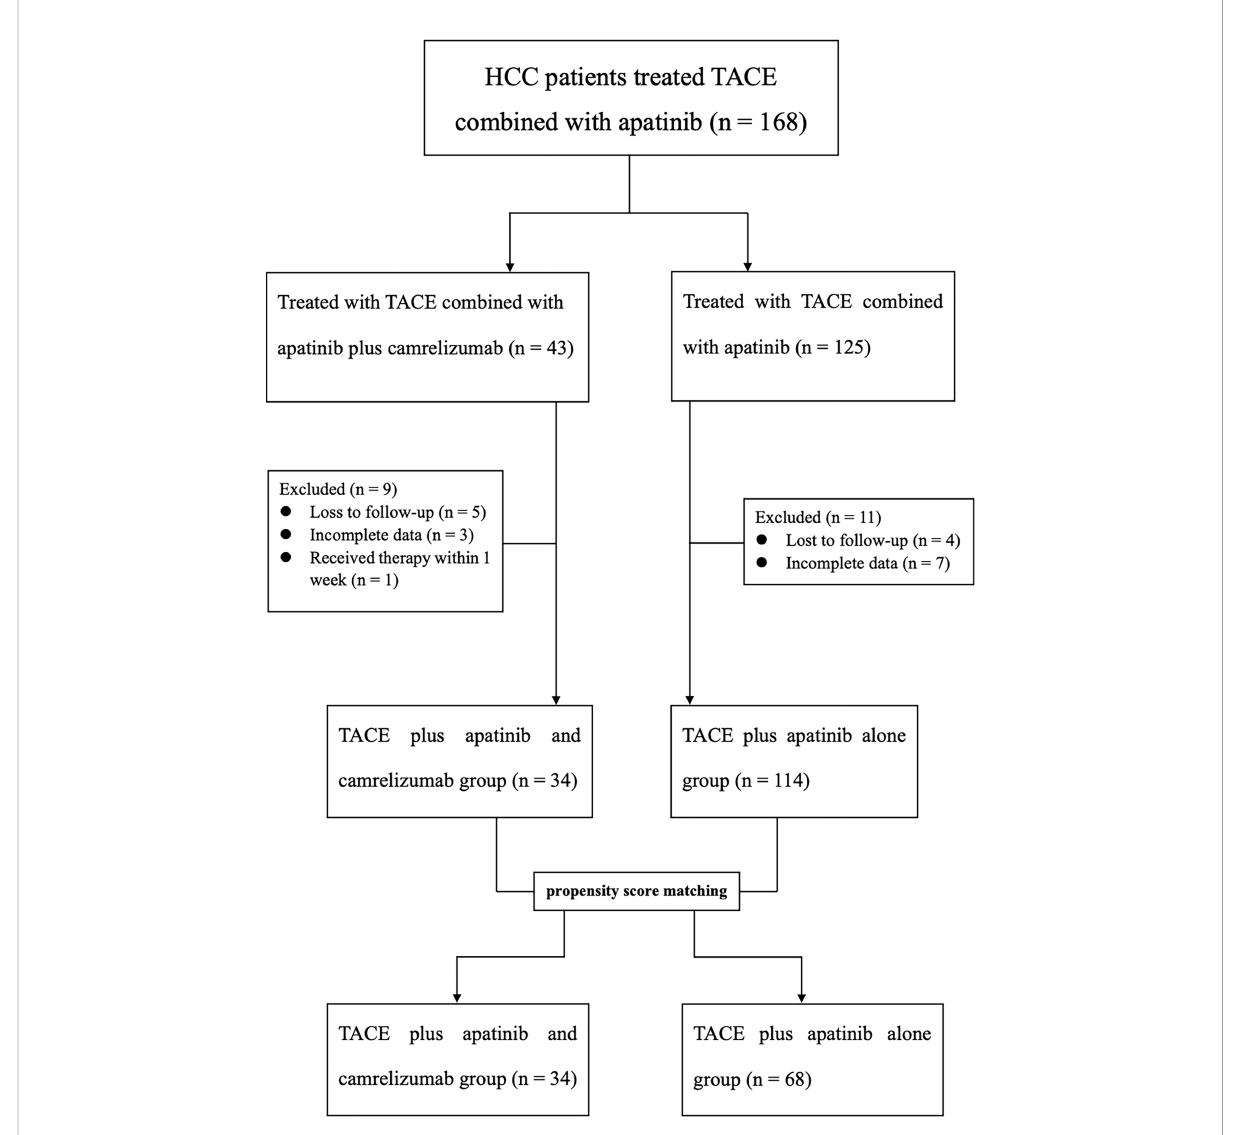
FIGURE 1 Flow diagram of patient enrollment. HCC, Hepatocellular carcinoma; TACE, Transarterial